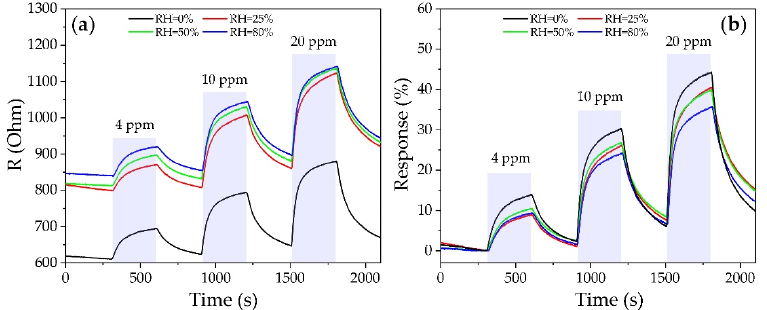
Figure 12. Sensor signal variations when detecting 4–20 ppm ethanol at 225 °C and different RH (0–80%): resistance ( a ) and sensor response ( b ).